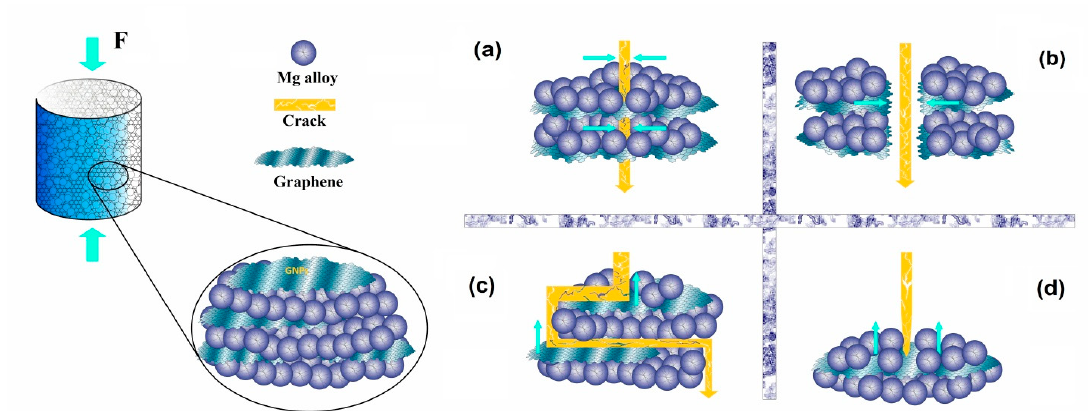
Fig. 12 Figure 12. Schematic diagram showing the pull-out ( a ), crack bridging ( b ), crack deflection ( c ), and crack tip ( d ) shielding mechanisms by